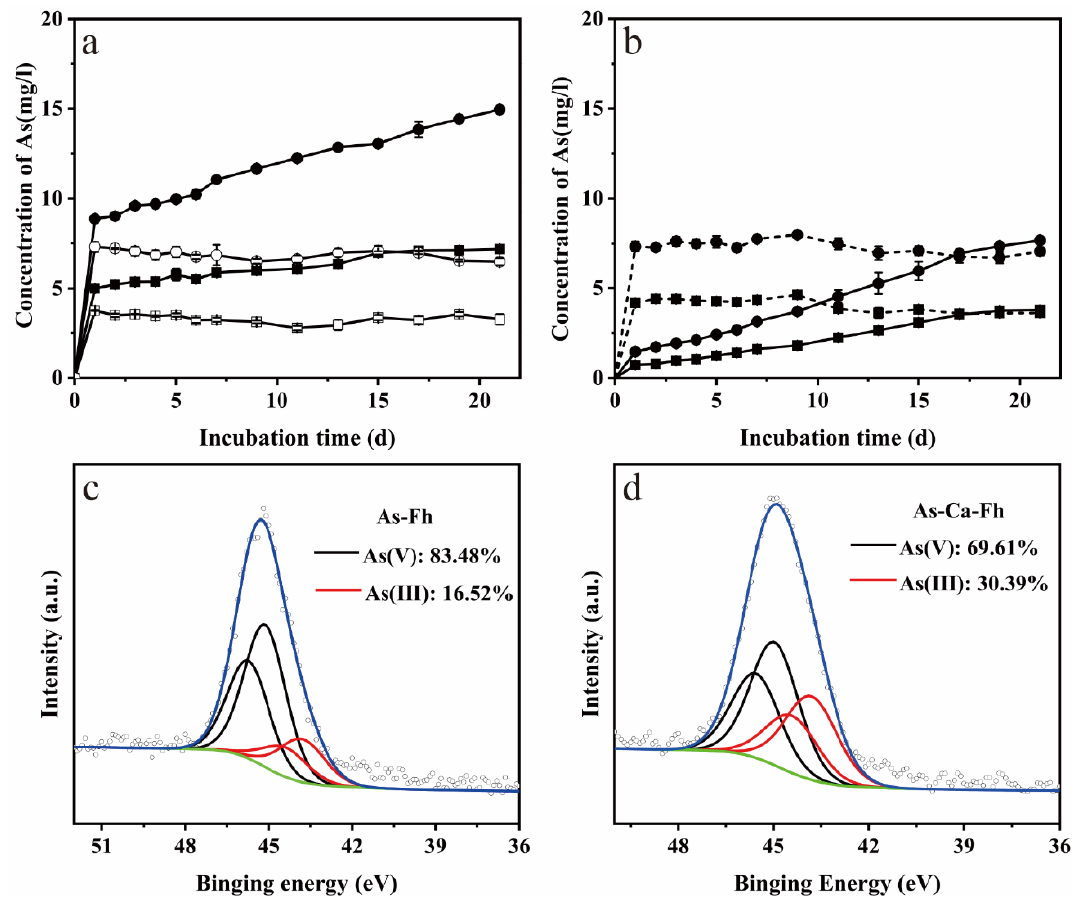
Figure 7. Measured total As ( a ), As(III) (solid line), and As(V) (dotted line) concentrations ( b ); XPS analyses of As species in the surface region of As-Fh ( c ) and As-Ca-Fh ( d ) where the blue and green color lines stands for photoelectron spectral lines of arsenic and the baseline. Squares ■ and circles ● in picture (a) and (b) represent As-Fh and As-Ca-Fh, respectively; the corresponding hollow shape in picture (a) ( □ , ○ ) represents sterile treatment. The hollow shape in ( c , d ) means the same thing as the blue color line in it (the photoelectron spectral of arsenic). The difference is that hollow shape circles stand for the data point and the blue color line is the fitted line for hollow shape